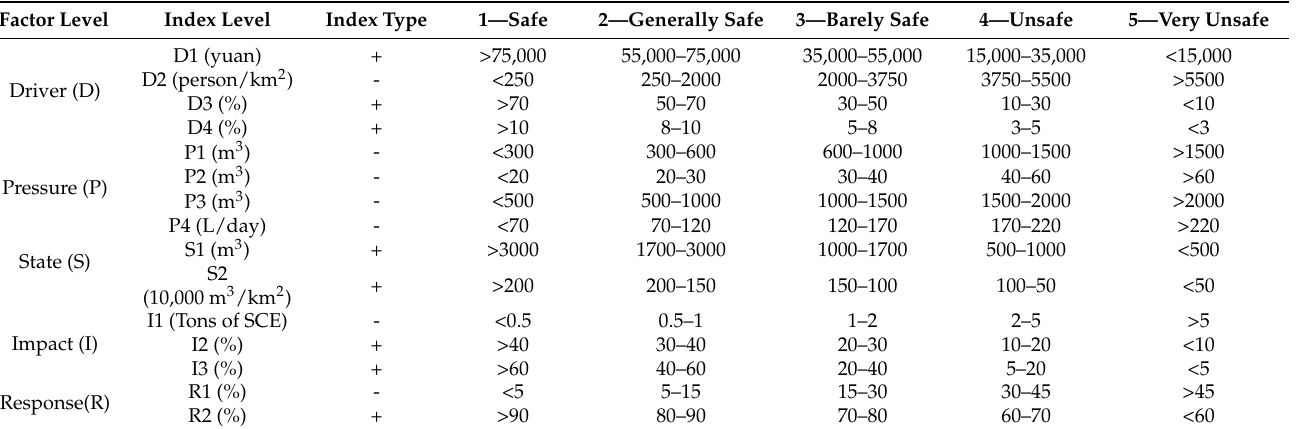
Table 2. Grades of water resource security